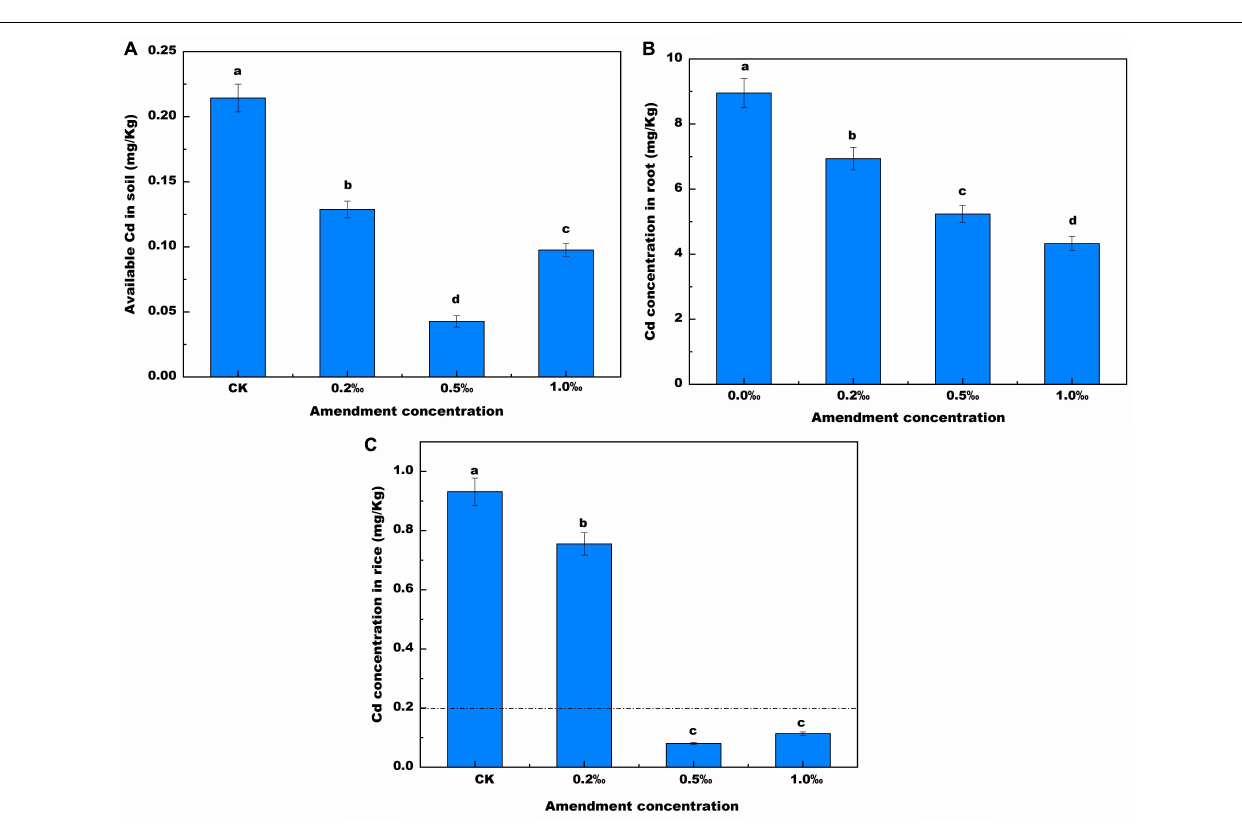
FIGURE 2 | Available Cd in soil (A) , Cd concentration (B) in root and in the rice (C) with different concentration of amendment. Values are means ± SD ( n = 3). Different letters above the bars indicate the signifcant differences at p <